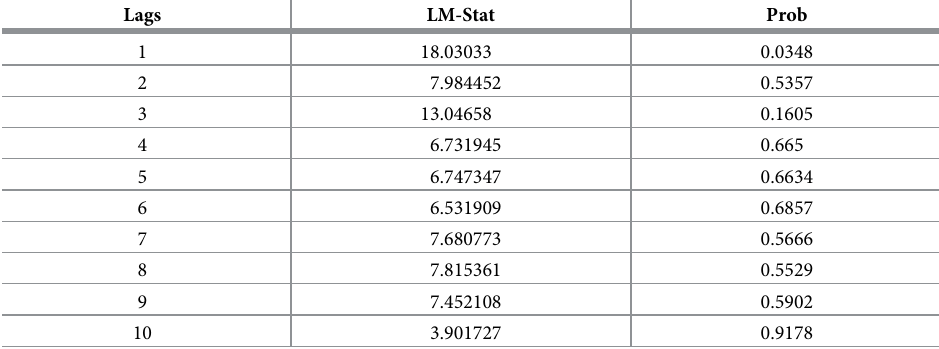
Table 10. Serial correlation LM test for Swiss data when P = 2 (proposed model).